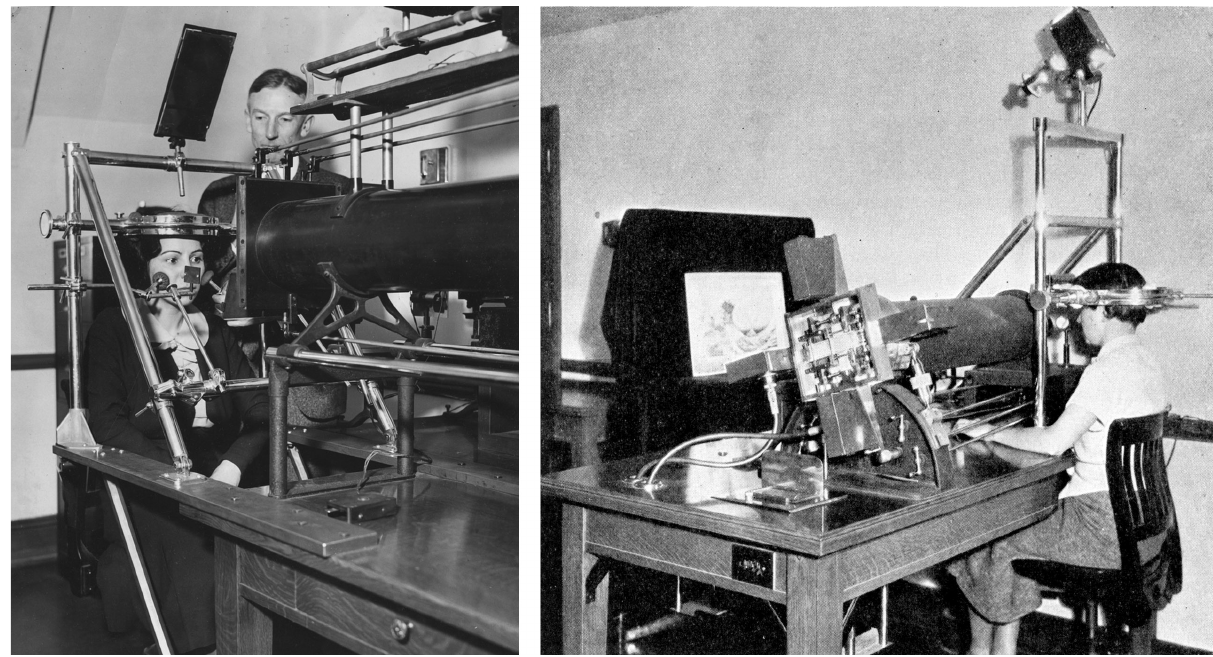
Figure 2. Left, Buswell looking over a participant in a study of eye movements; the photograph is undated and it probably shows apparatus for recording eye movements during reading. (Photograph courtesy of University of Chicago Photographic Archive, [apf1- 02381], Special Collections Research Center, University of Chicago Library.) Right, Buswell’s apparatus specially constructed for photographing eye movements when viewing pictures; the picture presented to the observer is The Wave by Hokusai. (Plate V in Buswell,